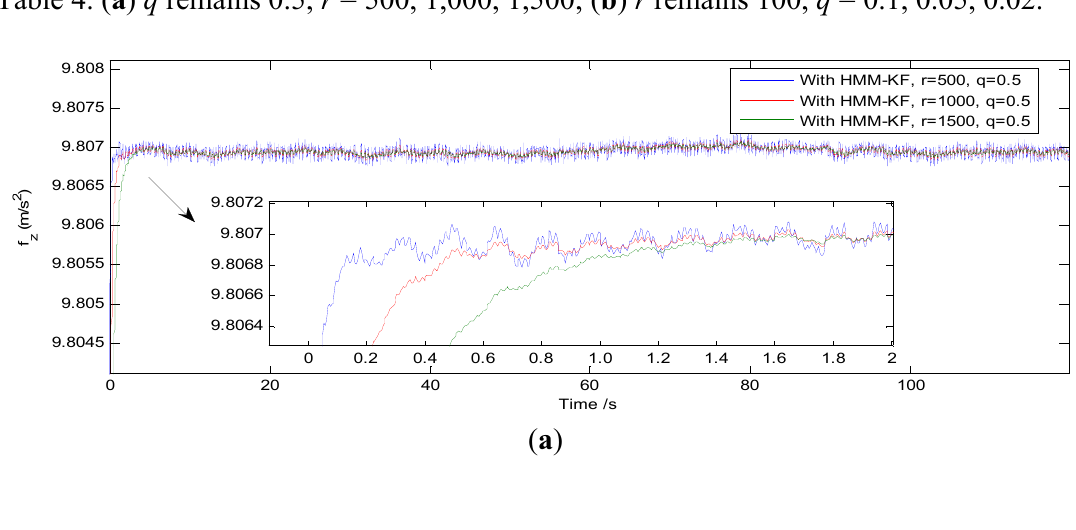
Figure 8. Comparison of the HMM-KF filtering results using the different parameters